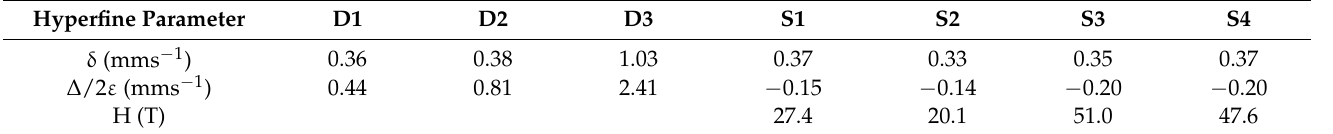
Figure 11. Room temperature 57 Fe Mössbauer spectra recorded from the Rokle samples: reference, 4H: close to heater interface, 5M: middle, and 6G: close to granite interface; i.e., at 1.67 cm, 5.00 cm and 8.33 cm from the heater contact, respectively. Table 7. Hyperfine parameters obtained from the fit of the spectra presented in Figure 12.